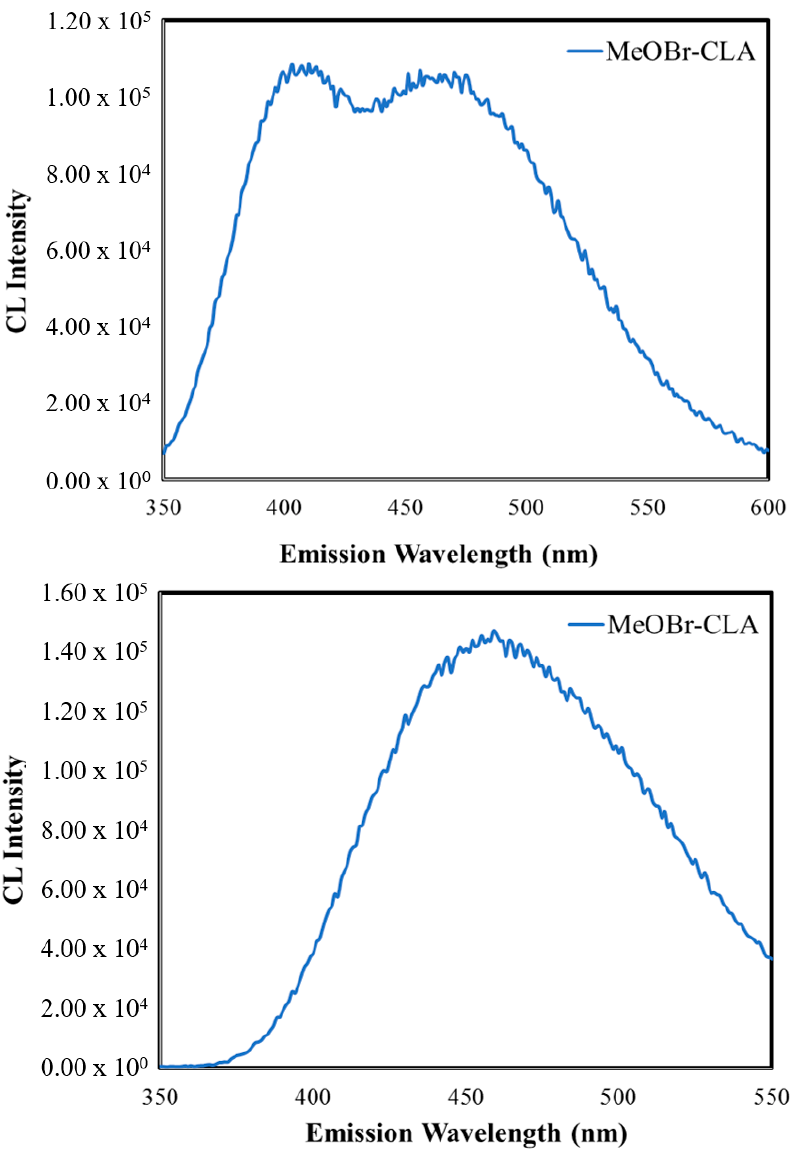
Figure 4. CL spectra for MeOBr-Cla in DMF with the addition of either sodium acetate buffer pH 5.2 (1%) (top) or NaOH (0.1 M) (bottom).